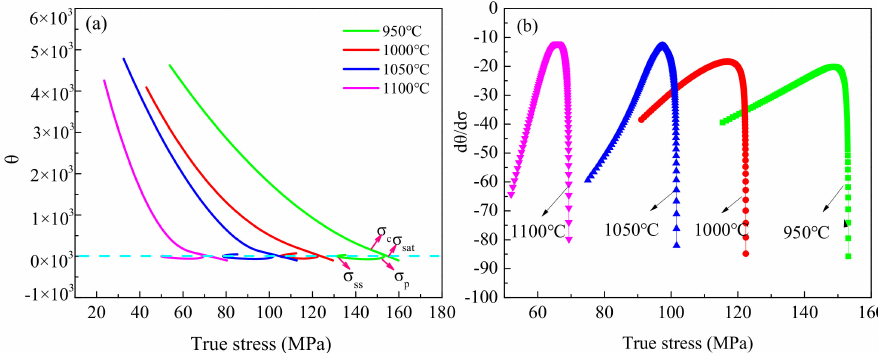
Figure 8. ( a ) θ - σ curves and ( b ) d θ / d σ - σ curves of the fine-grained specimens at a strain rate of 0.01 s − 1 for di ff erent deformation